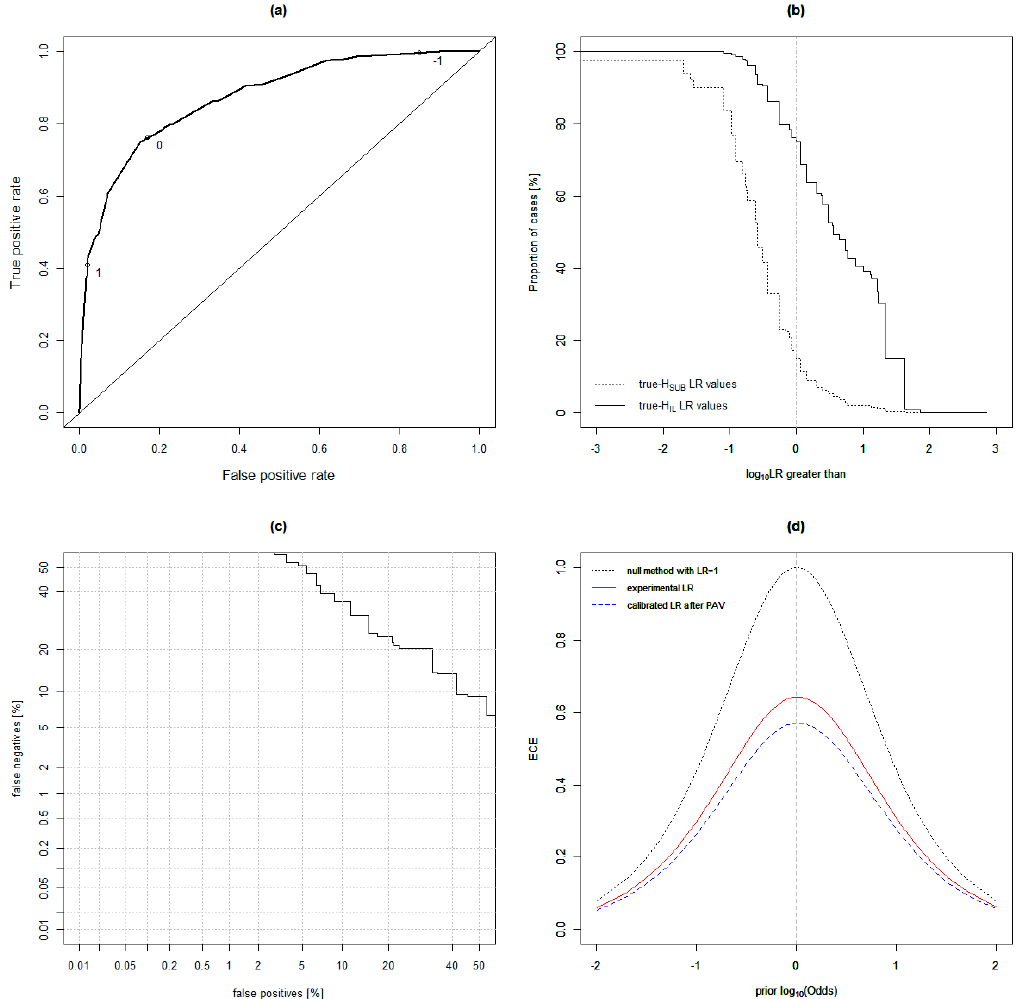
Figure 5. Plots showing the performance of a model based on distribution A from Table 1 and the pooled covariance for the IL and SUB classes (i.e., LDA model) using Equation (1). Plots include: ( a ) the ROC plot with LLR cutoff points labeled, ( b ) the Tippett plot, ( c ) the DET plot and ( d ) the ECE plot.